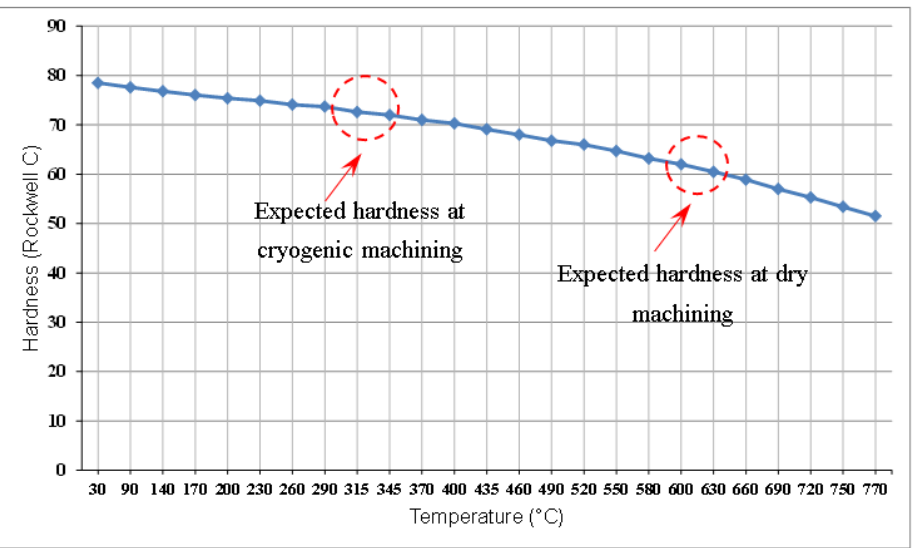
Figure 13. Temperature vs hardness relationship for tungsten carbide cutting tool, adapted from Groover [32].